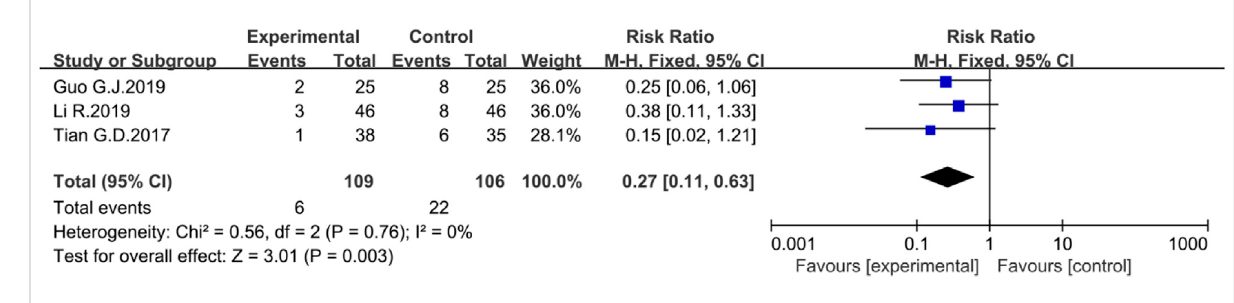
FIGURE 8 Forest plot displaying the results of the Meta-analysis for recurrence rate.